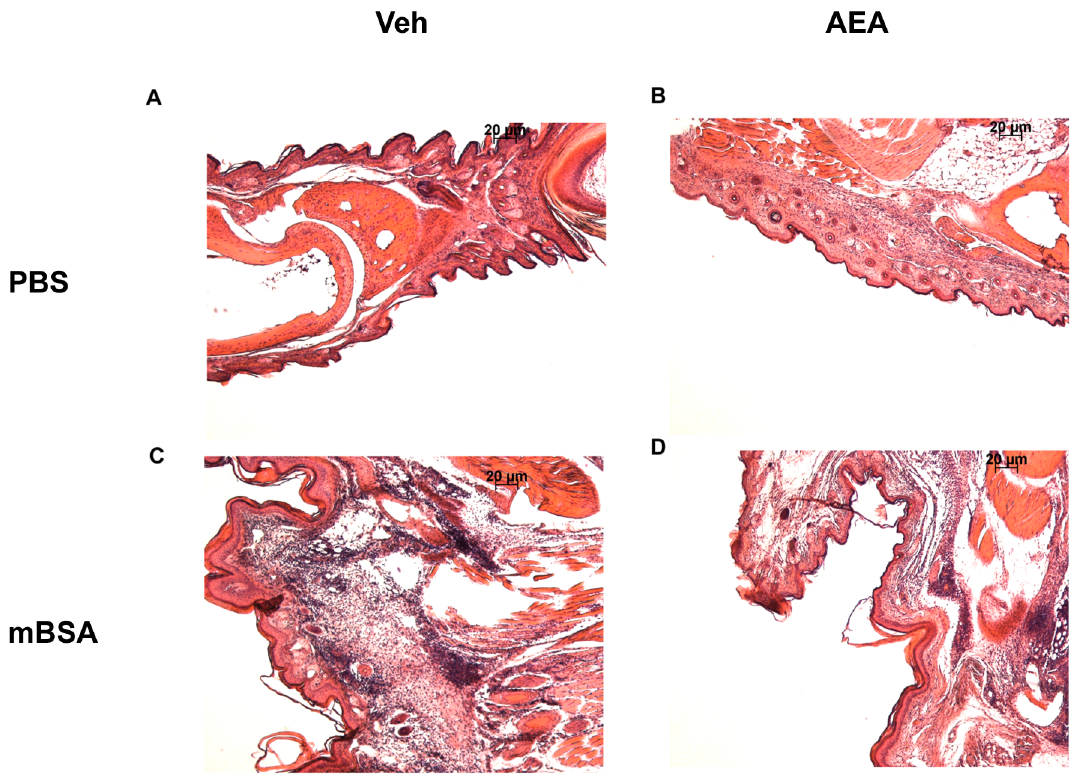
Figure 2. Histopathological analysis of mBSA rechallenged footpad. Mice were sensitized with mBSA and treated with either vehicle [A, C] or AEA [B, D], and rechallenged with either PBS [A, B] or mBSA [C, D], as described in Fig 1. The footpad was isolated and fixed/decalcified in Cal-Rite. The footpad was then embedded in paraffin and sectioned into 6 m m sections and stained with Hematoxylin and Eosin. Pictures are representative of 2 individual experiments with n=5. Magnification: 10 6